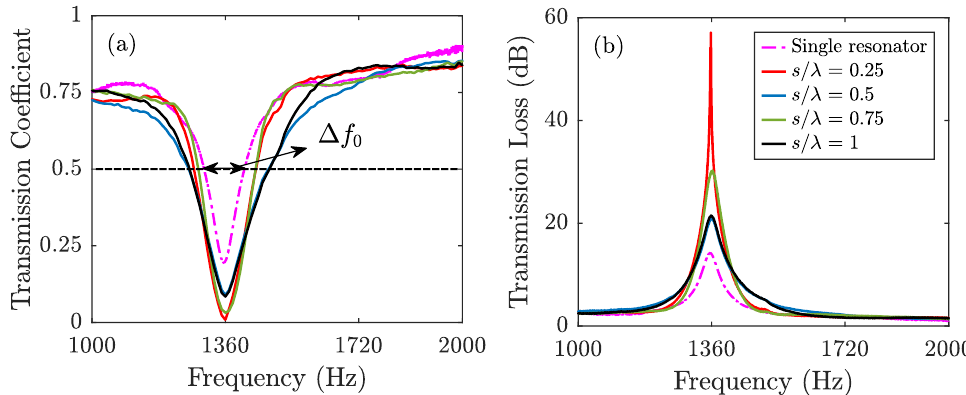
Figure 5. ( a ) Experimental results for transmission coefficient induced by different spacing ( s / λ ) configurations; ( b ) Experimental results for transmission loss induced by different spacing ( s / λ ) con-